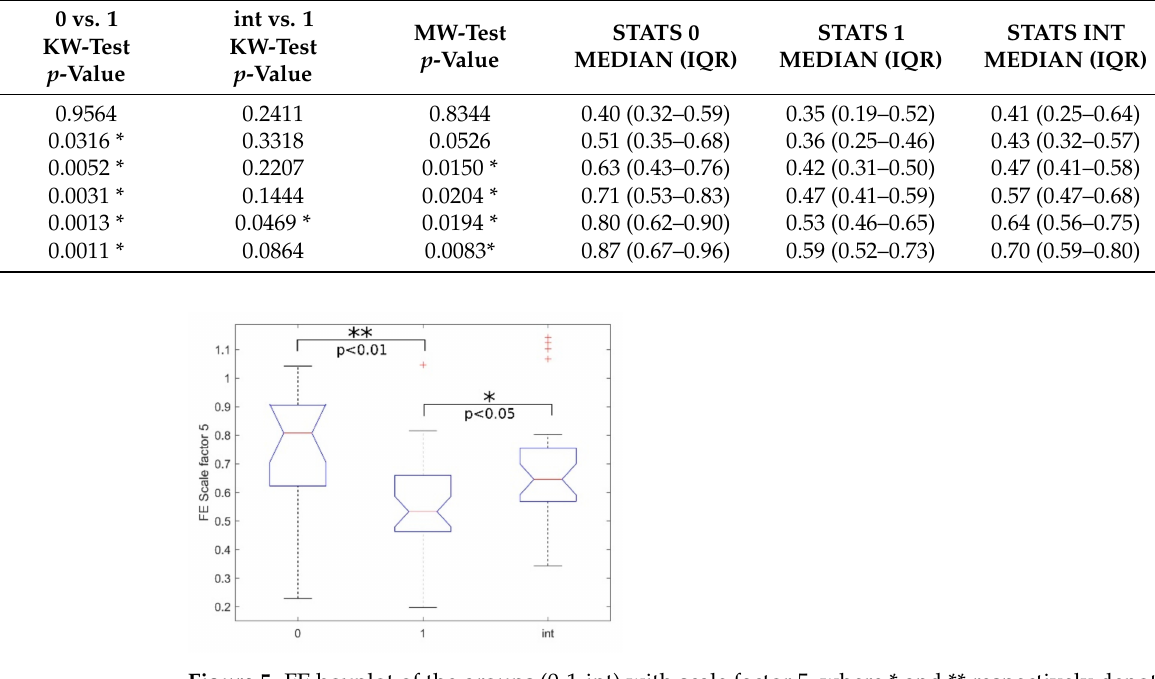
Figure 5. FE boxplot of the groups (0-1-int) with scale factor 5, where * and ** respectively denote statistically significant and highly statistically significant results obtained with the MCT